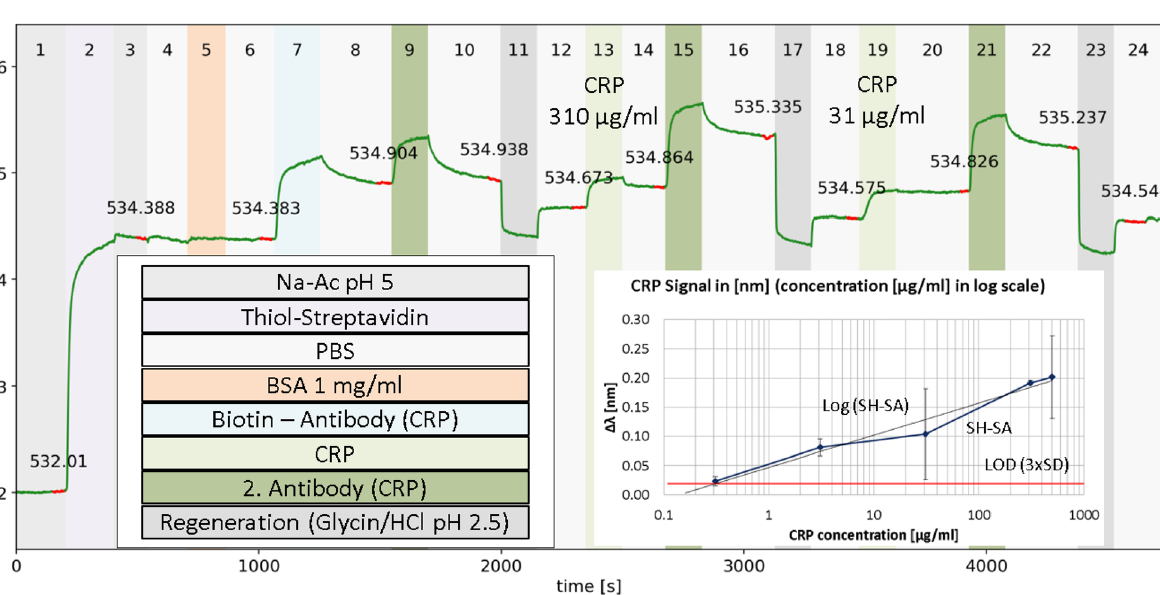
Figure 3. Example measurement for thiol-streptavidin mediated CRP binding assay. A substrate with gold nanoparticles modified by thiol streptavidin was utilized for attachment of CRP anti-bodies prior to binding of CRP. Inset right: Sensor response Δλ (mean values) in nm for 0.31; 3,1; 31, 310 and 500 µg/ml CRP. LOD is calculated with three times the standard deviation of the blank (PBS